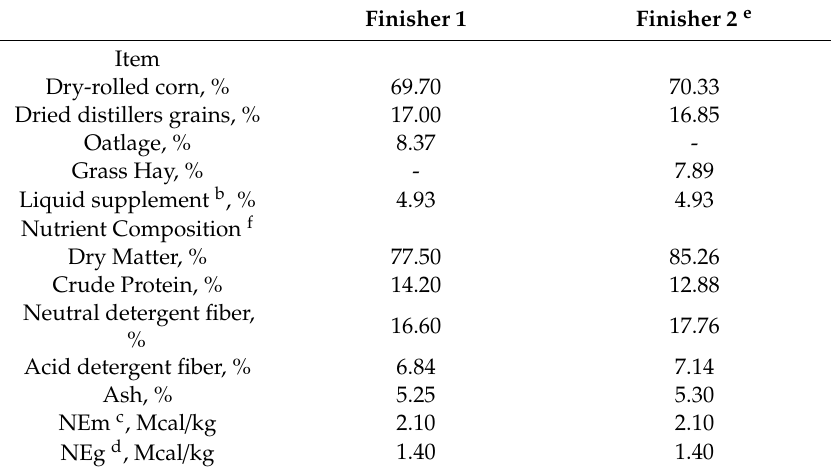
Table 1. Experiment 1: Diet composition (DM basis) a